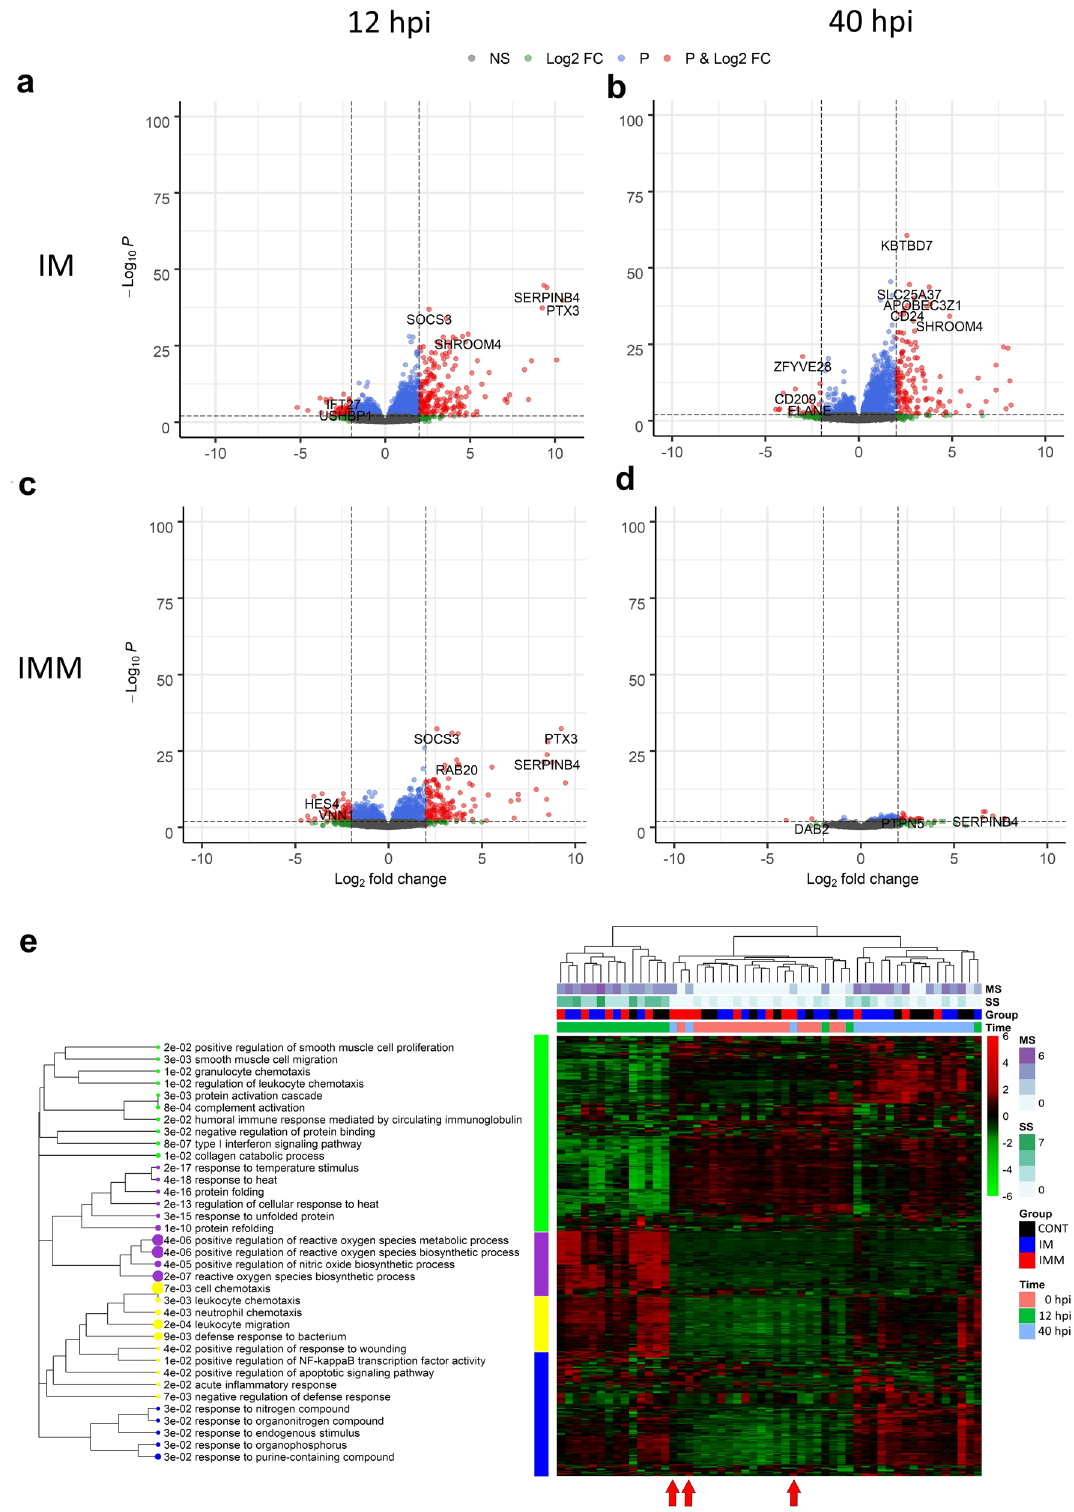
Fig. 3 Whole-blood transcriptomic analysis of the response of immunized cows during the E. coli mastitis course. DEGs at two time points (12 and 40 hpi) in comparison with 0 hpi were identi fi ed with Deseq2. Volcano plots comparing gene expression differences between 0 and 12 hpi ( a , c ), and at 0 and 40 hpi ( b , d ) are presented for the intramuscular (IM) and the intramammary (IMM) group, respectively. Red dots correspond to genes with a q value < 0.01 and a Abslog2FoldChange > 2. e Heatmap of the top 500 DEG in control and immunized groups during the course of infection is presented. Functional analysis was performed with ToppFun and a dendrogram shows the relationship among biological functions of commonly deregulated genes according to the mammary and systemic scores, the time, and the treatment group. MS mammary score, SS systemic clinical score. Red arrows indicate IMM cows with 0 and 40 hpi pro fi les that were undistinguishable (further designed as cured